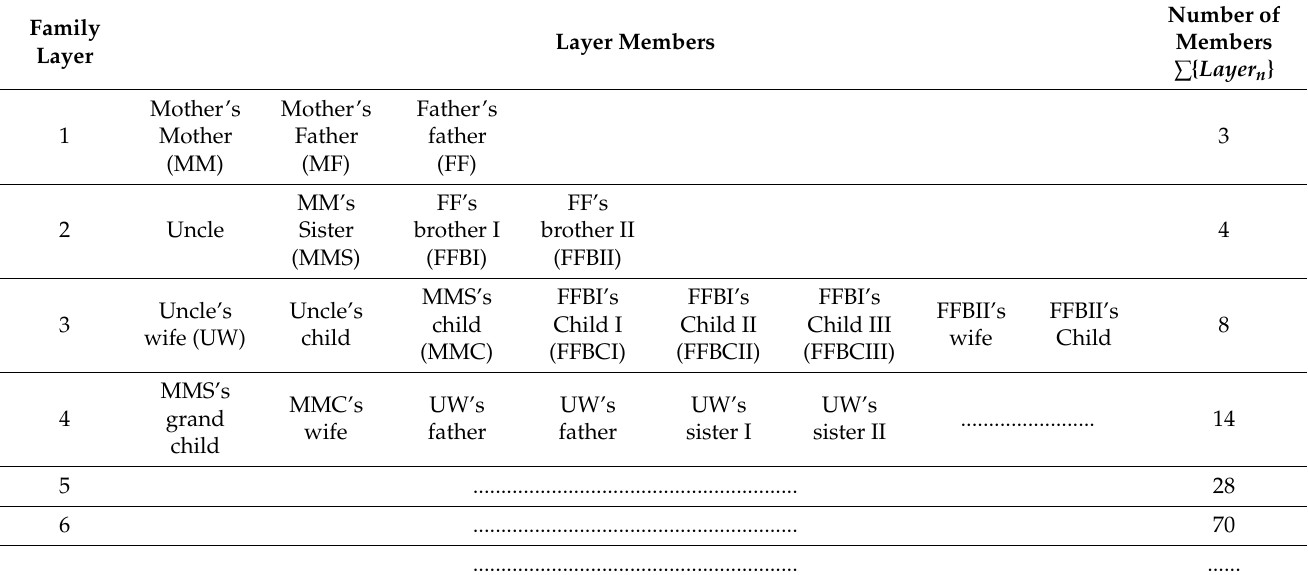
Table 3. Case family members.